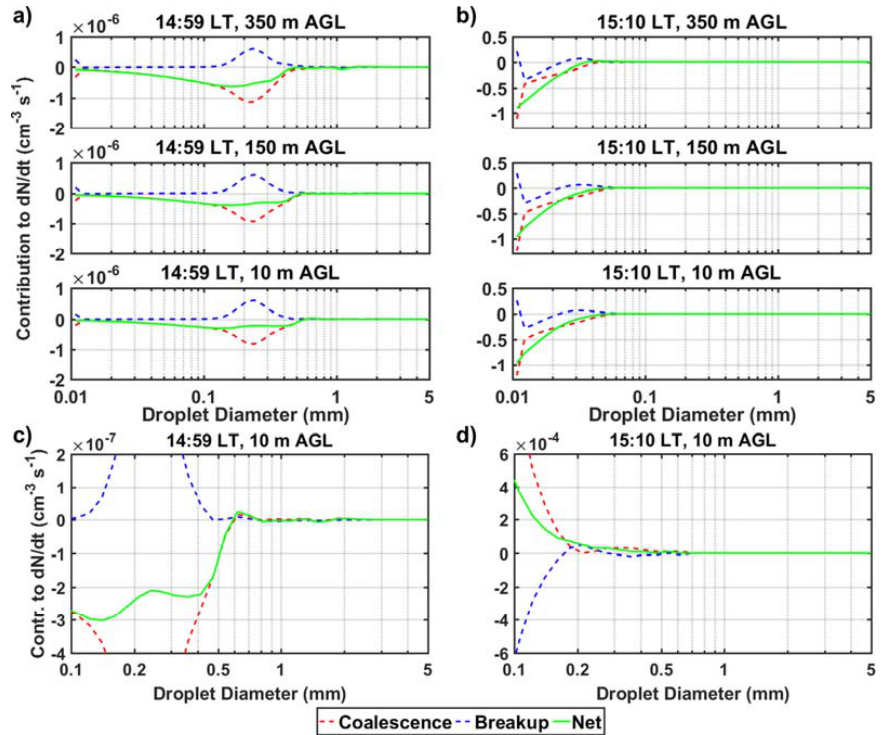
Figure 8. ( Top ) Contribution of coalescence and breakup processes to changes in simulated droplet number concentrations at three different heights (350-, 150-, 10-m above ground level (AGL)) in the simulation column before (14:59 LT; ( a )) and after (15:10 LT; ( b )) the activation of SFI in the model. ( Bottom ) Enlarged plots for 14:59 LT ( c ) and 15:10 LT ( d ) at 10 m AGL. This effect is also manifest in the temporal evolution of the R-DSDs within the fog layer proper (400 m), as shown in Figure 9b–d. As a result of enhanced coalescence efficiency, the number concentrations of small raindrops (0.2–0.7 mm) at 15:10 LT (marked by the second vertical line in Figure 9a–d) are significantly higher than the ones at 14:59 LT (marked by the first vertical line in increase in the number of small raindrops later contributes to the increase in the number and efficiency of collisions between small diameter ( d 2 < 0.6 mm) and larger diameter drops ( d 1). As